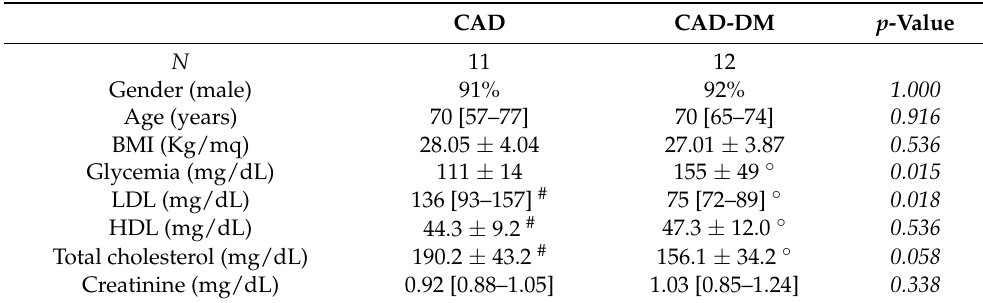
Table 1. Clinical profile, cardiovascular (CV) risk factors and therapies characterizing the coronary artery disease (CAD) cohort enrolled for this study. Patients have been categorized for the presence of diabetes mellitus (DM) as